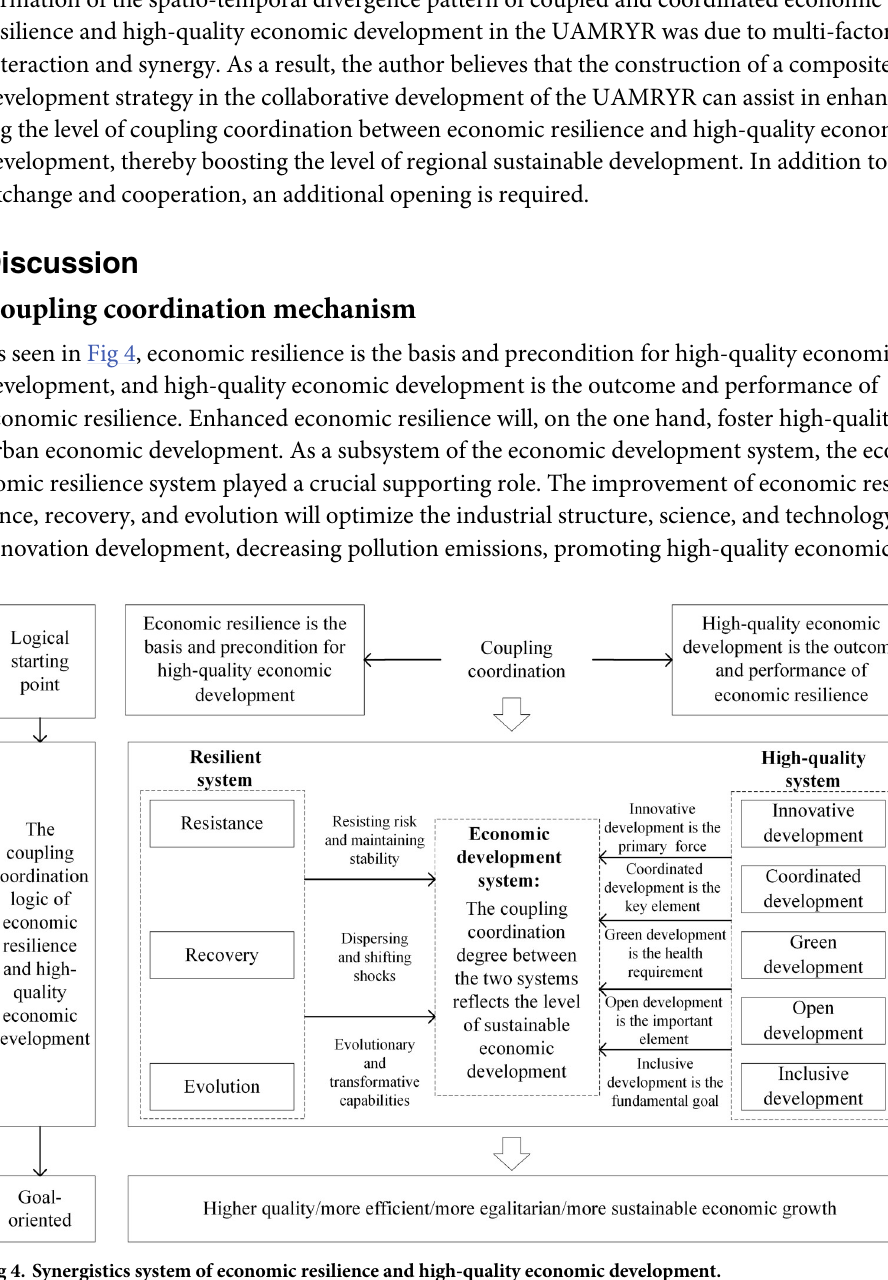
Fig 4. Synergistics system of economic resilience and high-quality economic